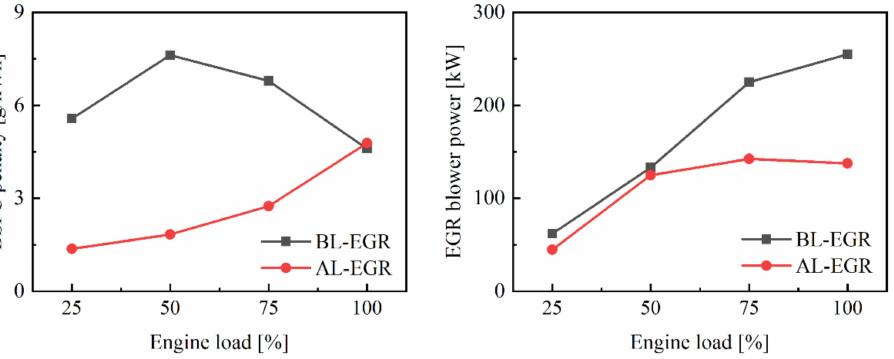
Figure 14. Engine BSFC penalty and EGR blower power of the BL-EGR and the AL-EGR engine configurations operating at the Tier III